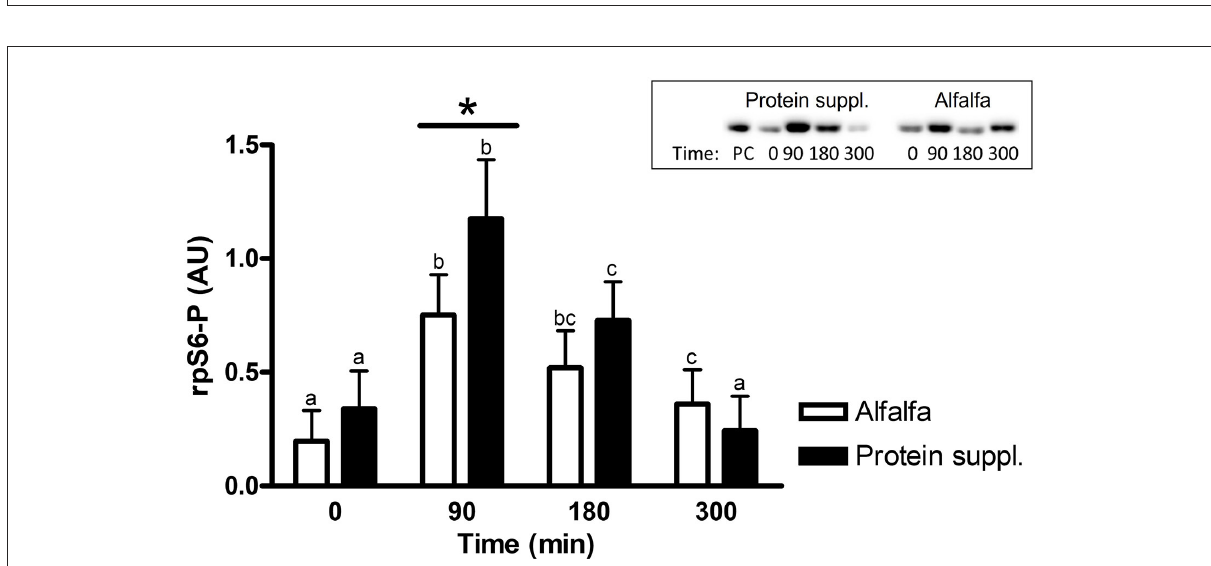
FIGURE4 Relative abundance of phosphorylated rpS6 protein in gluteal muscle samples post consumption of alfalfa pellets vs. a protein supplement. Effect of treatment by time interaction on gluteal muscle abundance of phosphorylated rpS6 protein at 0, 90, 180, and 300min post consumption of the protein supplement (black bars, n = 16) and alfalfa pellets (white bars, n = 14) in all horses. Results from a representative blot are shown as an inset. Each lane on the blot represents a time point from the same horse. PC: positive control. a,b,c Different letters indicate differences between timepoints within each protein source. * Indicates differences between protein sources within a timepoint. Effect of treatment by time interaction, P = 0.10. Values for abundance of phosphorylated rpS6 were normalized to total protein. AU, arbitrary units. Data presented as least square means ± standard error of the